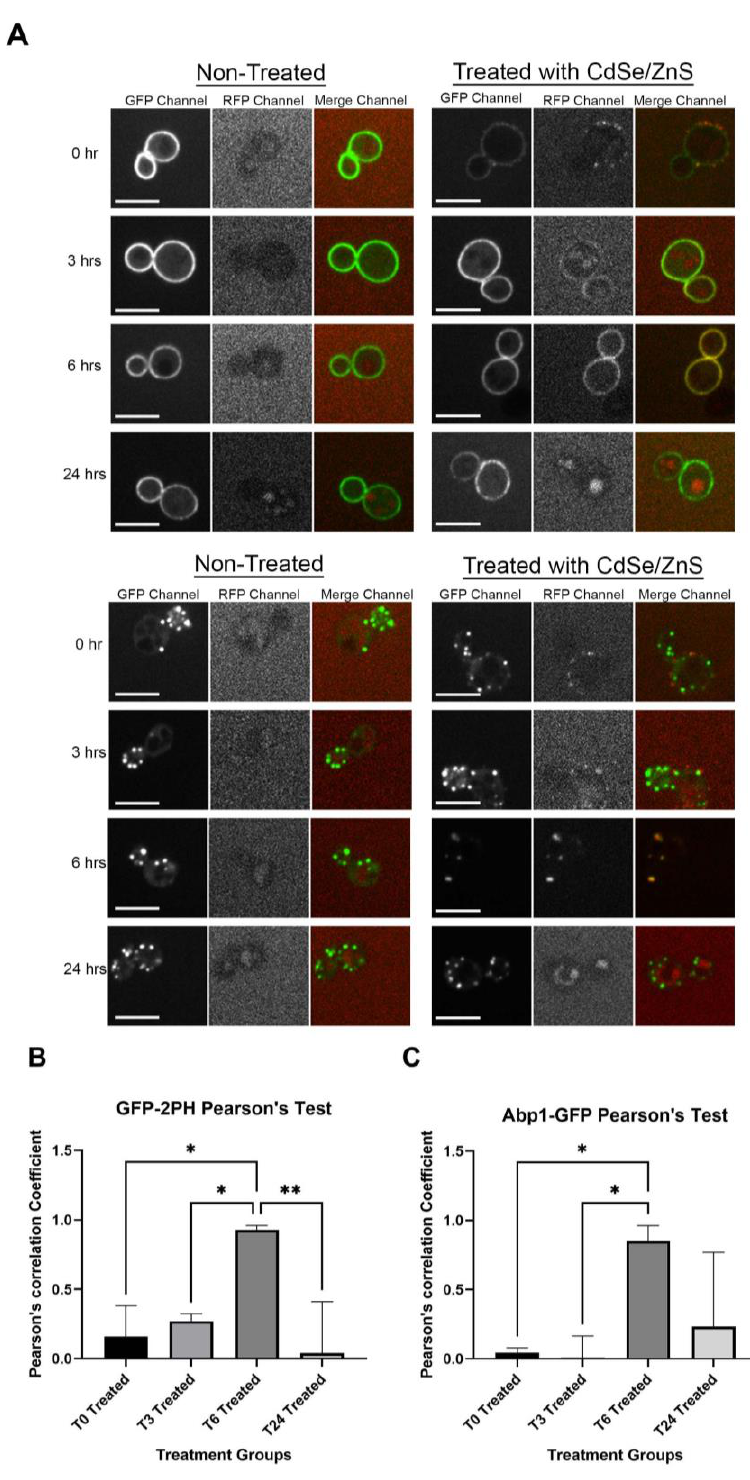
Figure 2. QDs’ intracellular trafficking. Cells expressing GFP-2PH or Abp1-GFP were cultured in SD-HIS for 0 h, 3 h, 6 h, or 24 h with or without QDs (4 µ g/mL). The images show different channels (in order: GFP, RFP, and merge) for control on the left and QD-treated on the right. The size bar is equivalent to 5 μ m. ( A ) Confocal microscopy images of the plasma membrane reference marker GFP-2PH (top) and confocal image of the early endocytosis reference marker (bottom). Images B and C show the graphs of Pearson’s correlation coefficient of QDs with different reference markers. ( B ) Graph for QDs and plasma membrane colocalization and ( C ) graph for QDs and the early endocytosis vesicle colocalization. * p < 0.05, ** p < 0.01.